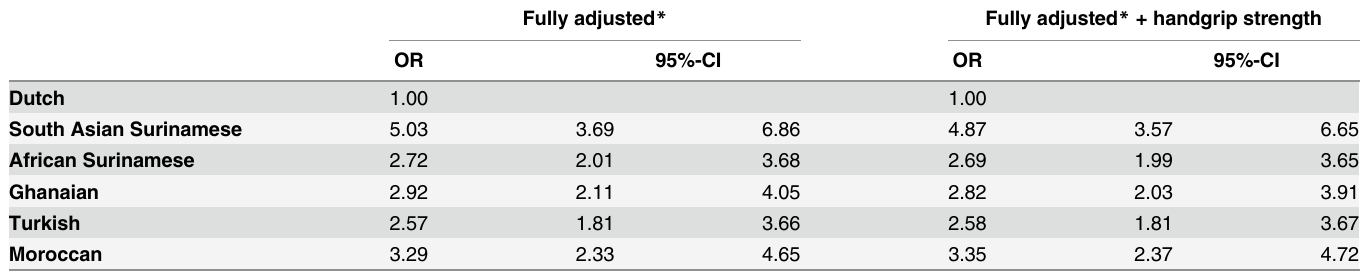
Table 3. Ethnic differences in type 2 diabetes mellitus, adjusted for known risk factors and handgrip strength.